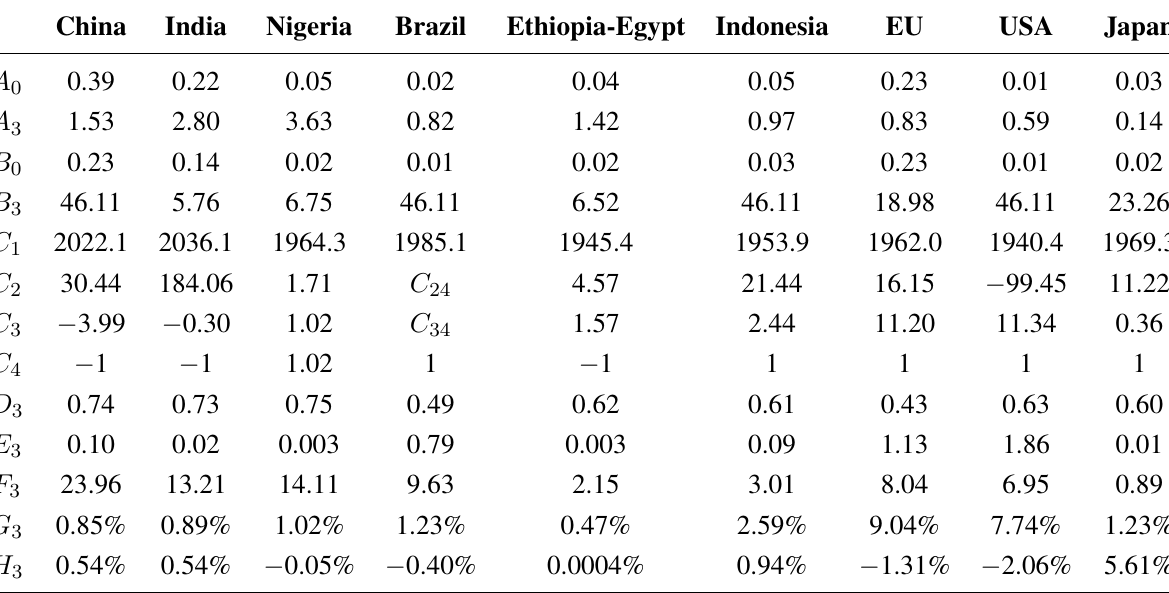
Table 3. Additional region-dependent